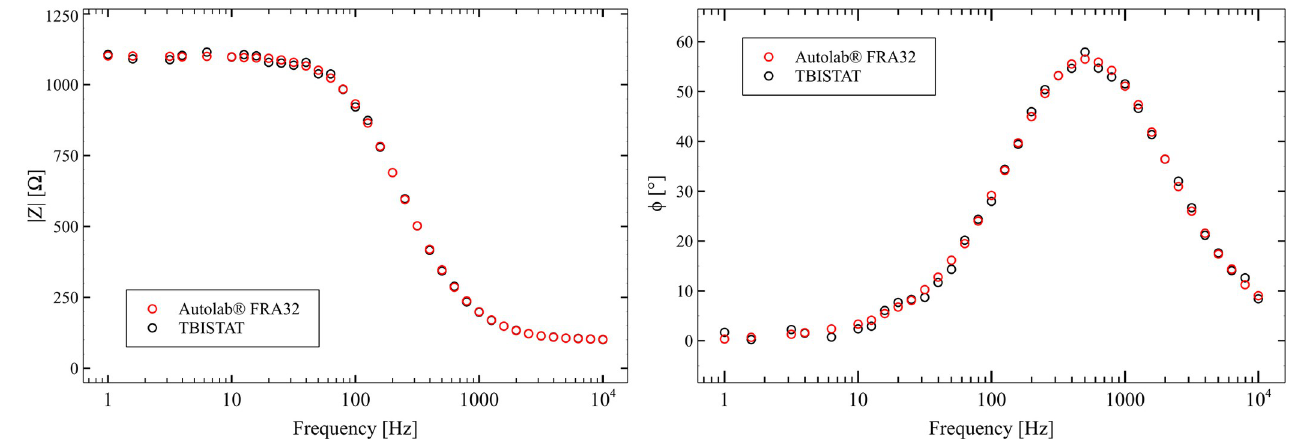
Fig 6. EIS magnitude and phase plots for TBISTAT and reference instrument for dummy cell excitation.